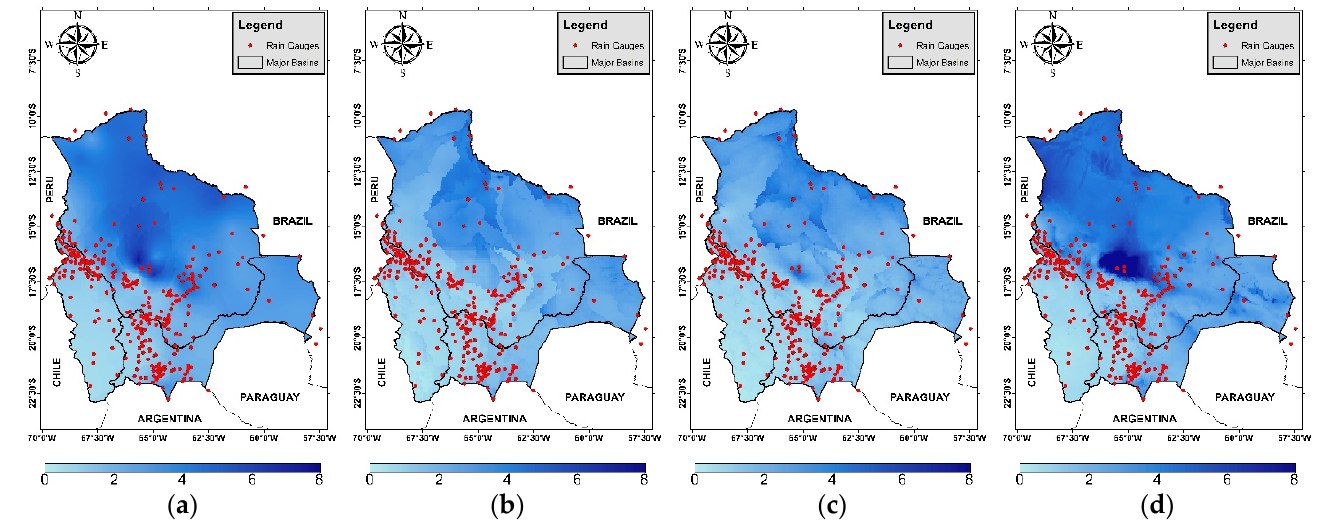
Figure 10. Average daily precipitation maps for the period 2001–2015 of: ( a ) rain gauges, ( b ) GS, ( c ) CH and ( d ) GMET. ( c ) CH and ( d )